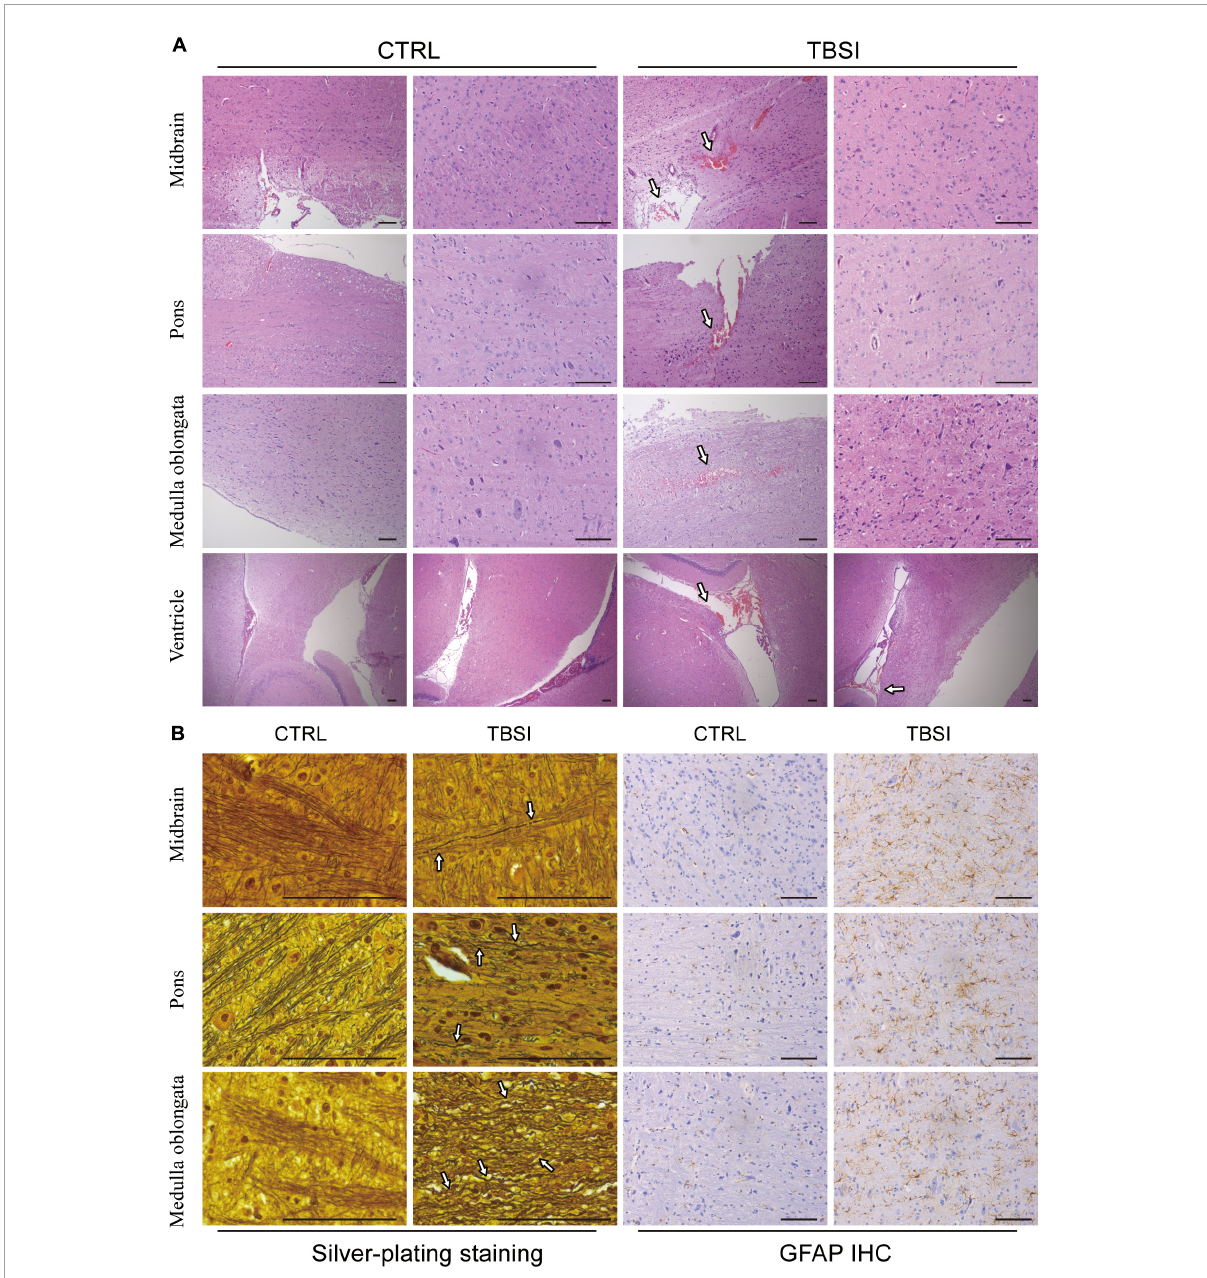
FIGURE2 Brainstem pathological analysis. (A) Hematoxylin and eosin (H&E) staining. Arrows point to the areas of bleeding. (B) Silver staining (Left) and GFAP staining (Right). Arrows point to disordered axons. Scale bar = 200 µ m.